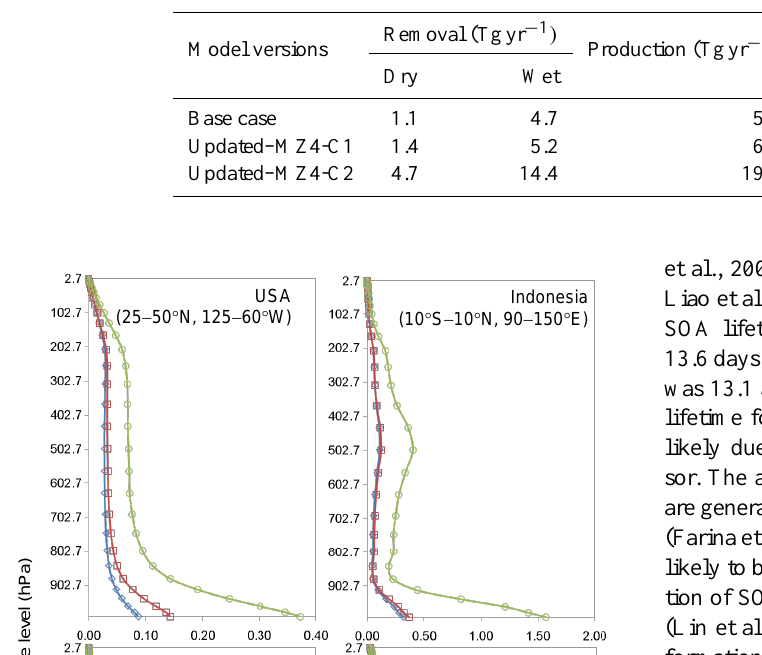
Table 4. Global SOA budget estimates.